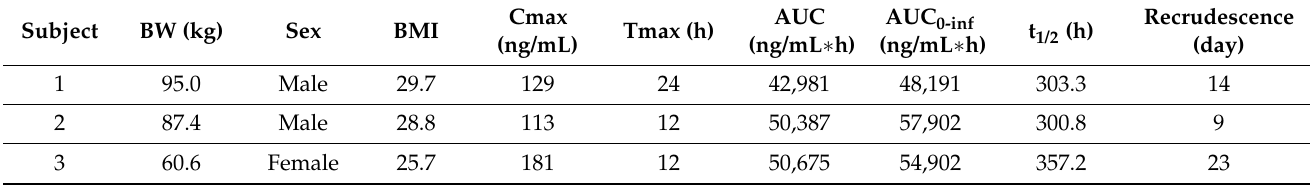
Table 4. Pharmacokinetic properties of TQ in human plasma ( n =